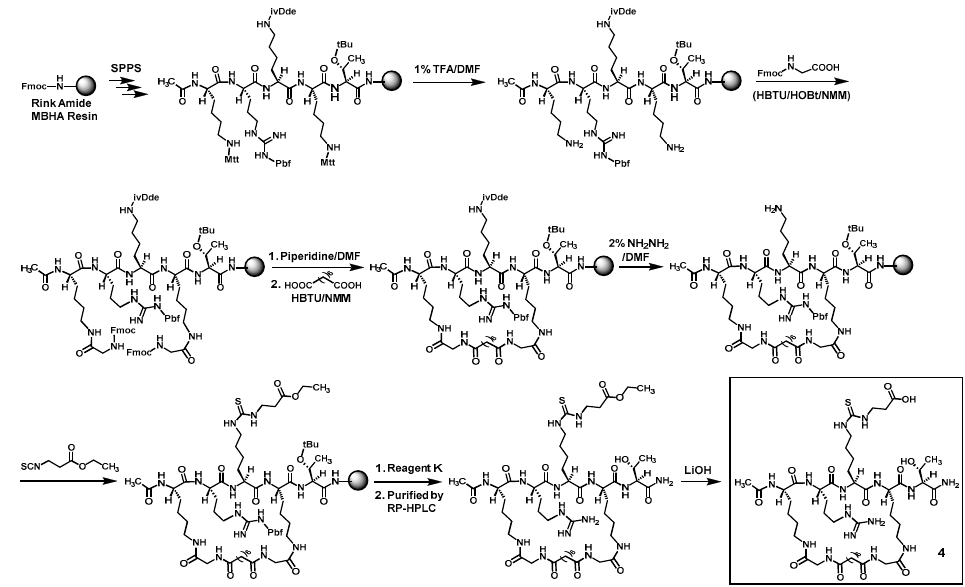
Scheme 1. The solid phase synthesis of compound 4 .